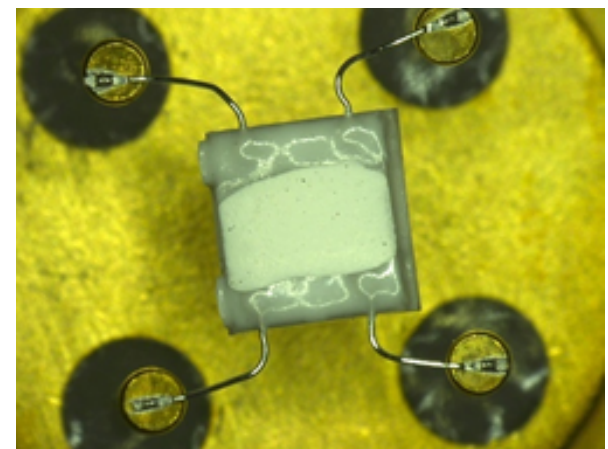
Figure 1. Optical micrograph of the sensor. The size of the sensor element is 2mm × 2.3mm. The white material is TiO 2 , whereas the grey material is the alumina